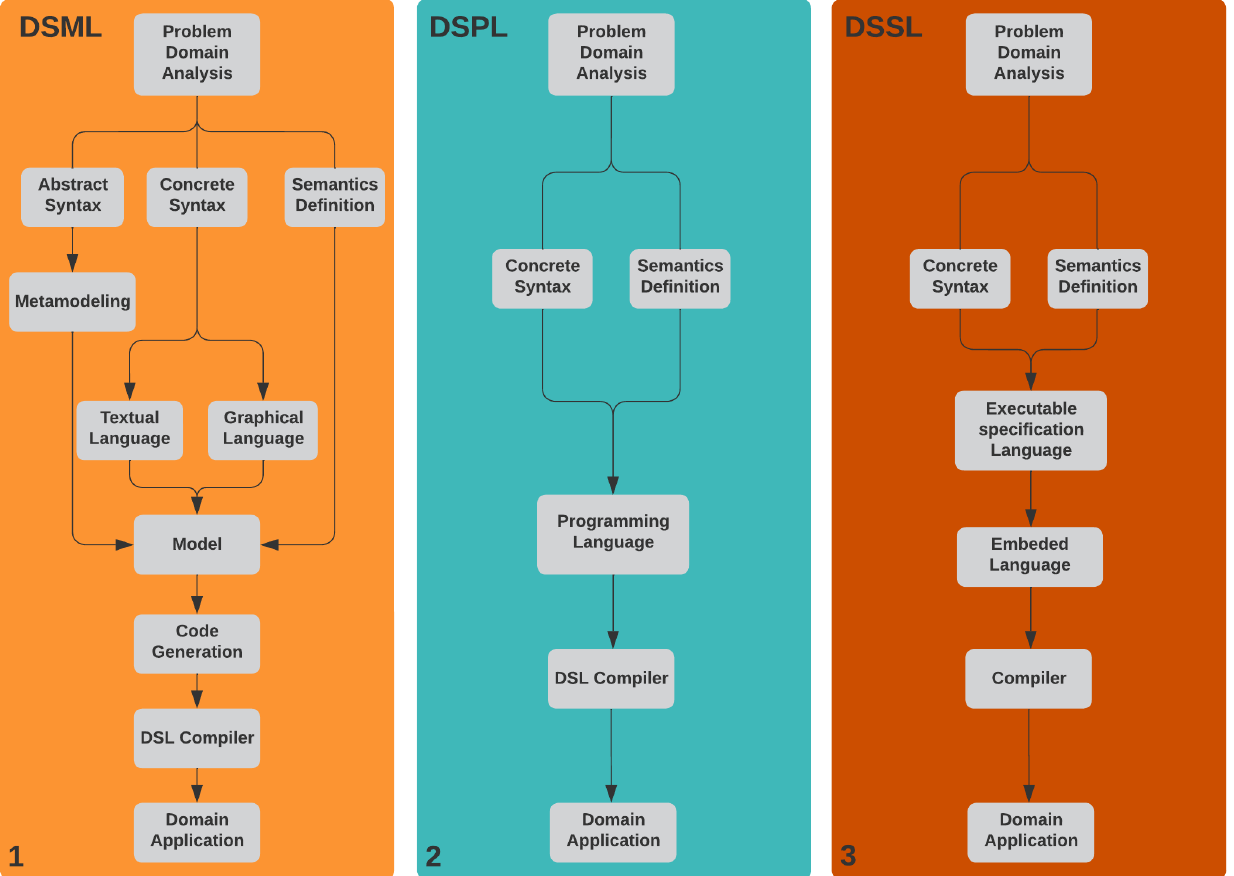
Figure 1. Different DSL types of elements.